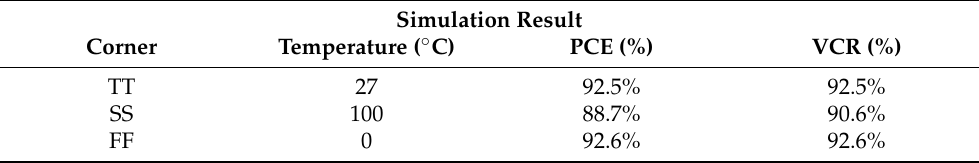
Figure 10. Power conversion efficiency (PCE) versus different output load. Table 1. Power conversion efficiency (PCE) and voltage conversion ratio (VCR) versus process and